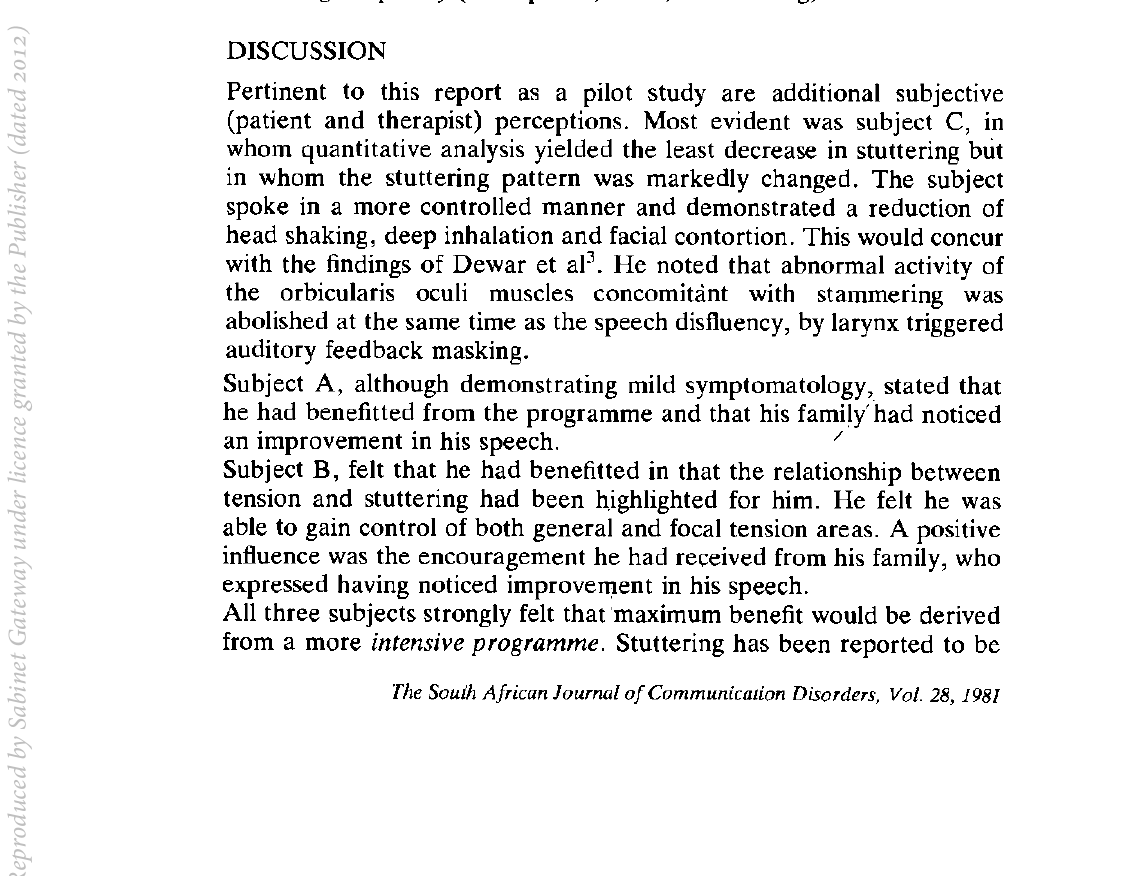
Figure 3: A comparison of the three different methods of analysing stuttering frequency (free speech, TAT, and